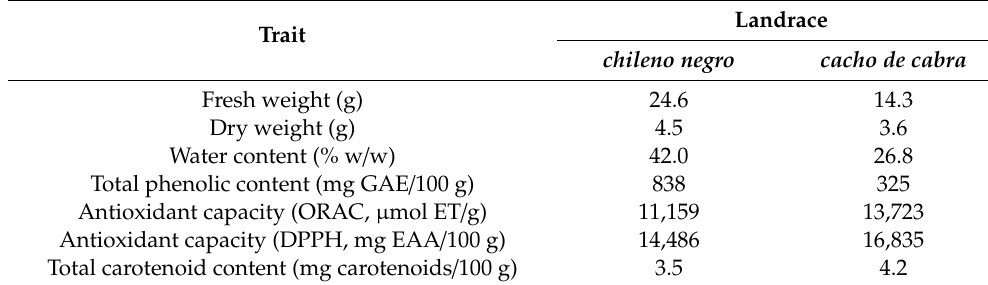
Table 3. Fruit measurements in two chili pepper